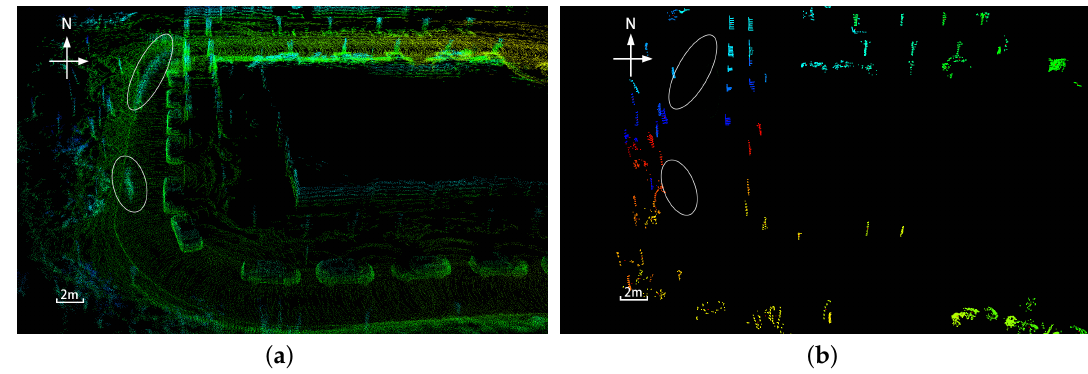
Figure 2. Demonstration of PointCloudMap and ClusterMap built from the same dataset. ( a ) PointCloudMap contains trailing smears caused by dynamic pedestrians; ( b ) ClusterMap reserves only static objects.